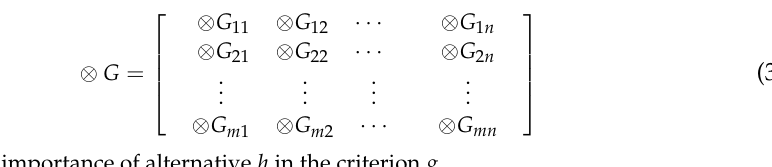
Table 3. The linguistics scale with grey numbers [76]. Linguistics Scale Grey Number [ x , x ] Very Poor (VP) [0, 1] Poor (P) [1, 3] Medium Poor (MP) [3, 4] Fair (F) [4, 5] Medium Good (MG) [5, 6] Good (G) [6, 9] Very Good (VG) [9,